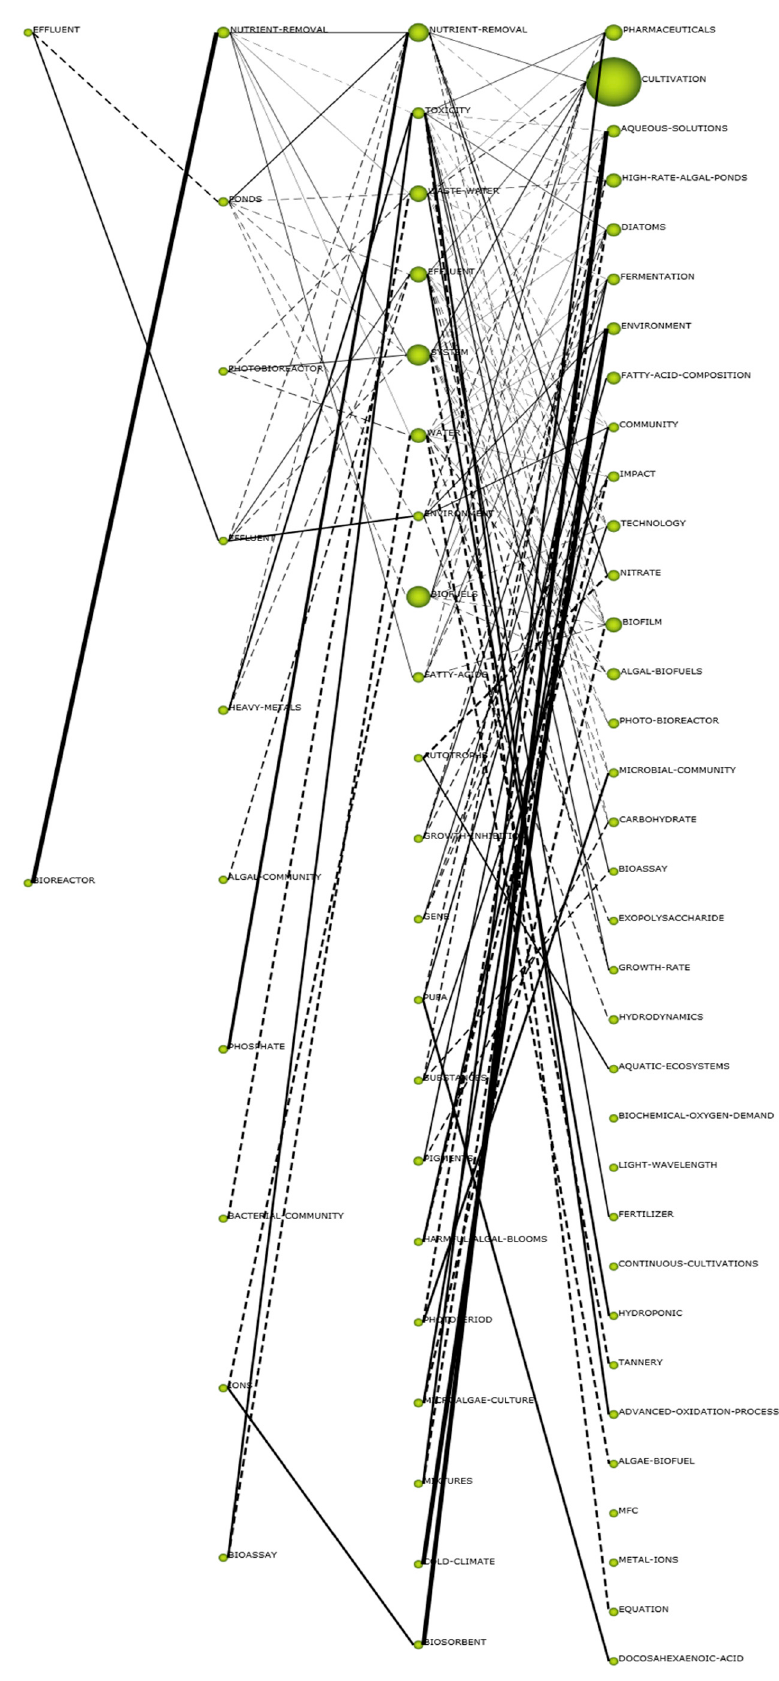
Figure 2. Evolution of thematic areas between 1981–2018 (SciMAT output).